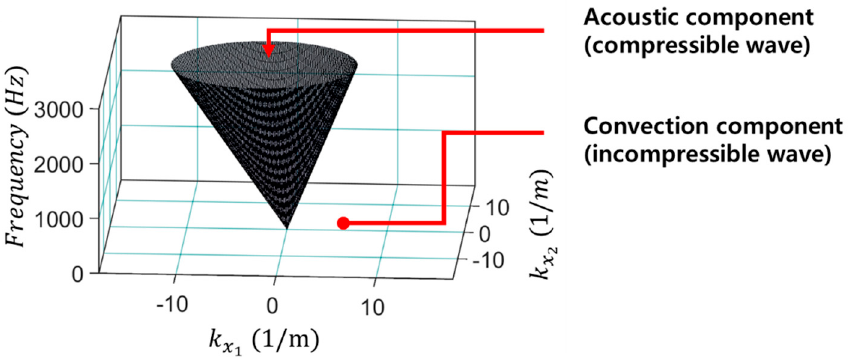
Figure 1. Illustrative slanted Dirac cone separating incompressible and compressible parts in the three-dimensional periodogram: U 0 = 300 km / h and c 0 = 343 m / s.